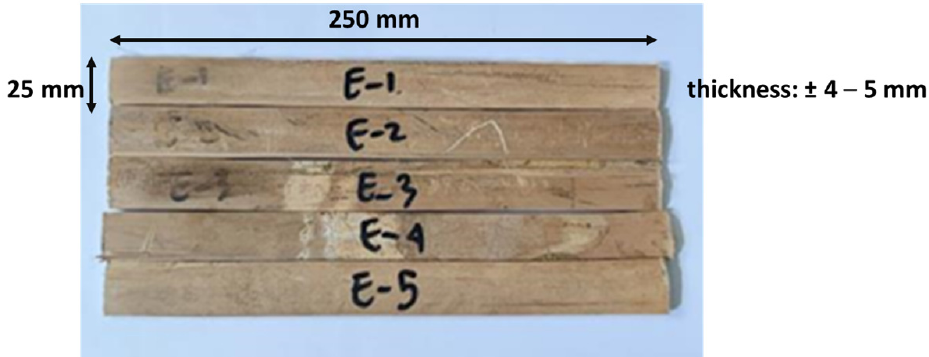
Figure 5. Bamboo specimens for tensile test.